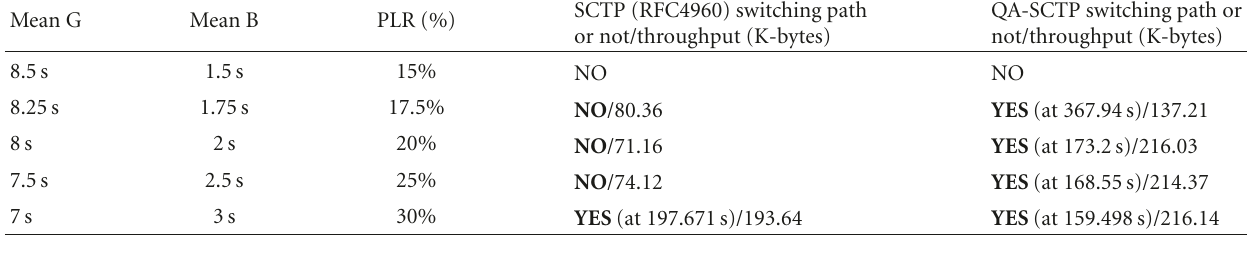
Table 2: Experimental data for quality-aware SCTP path error detection mechanism.